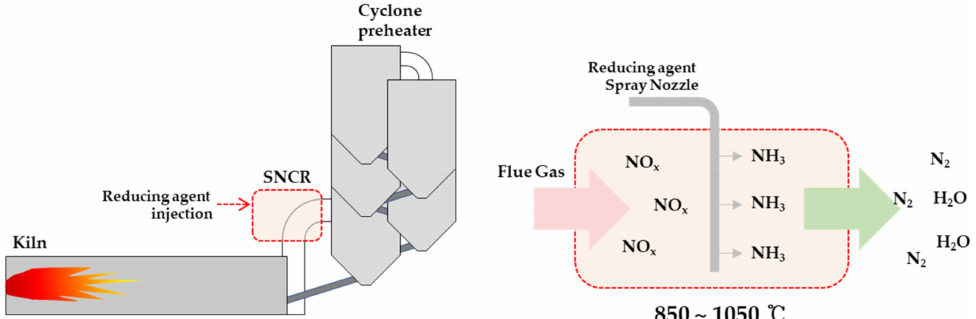
Figure 11. SNCR location and mechanism in the cement production process for DeNO x .